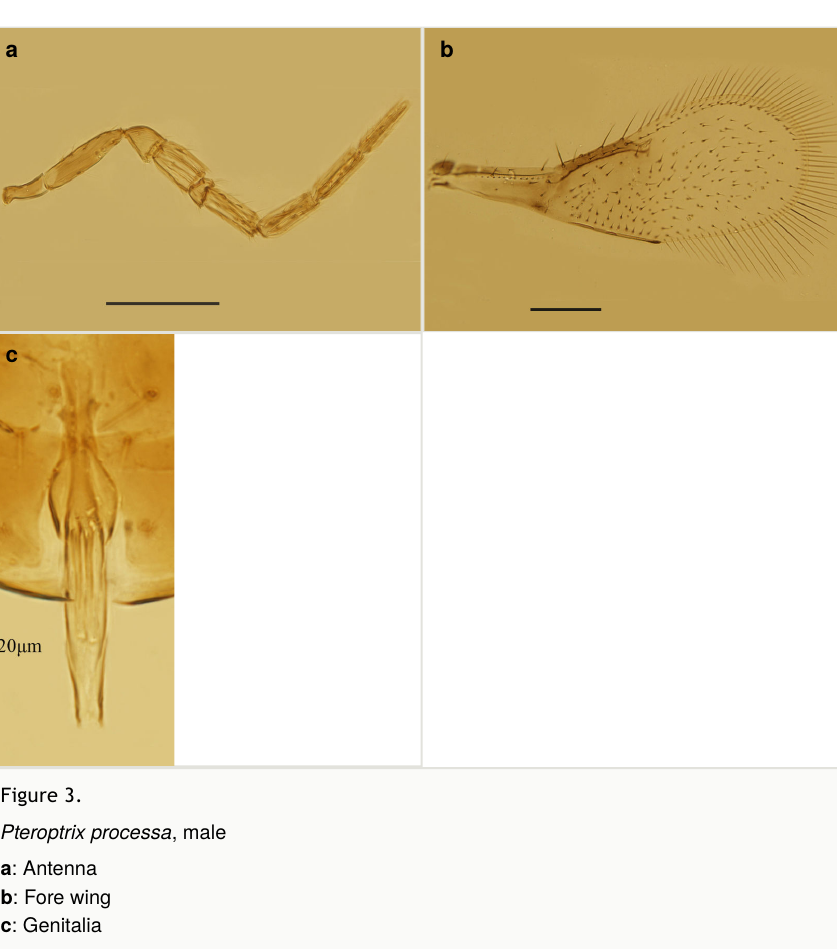
Pteroptrix processa ,